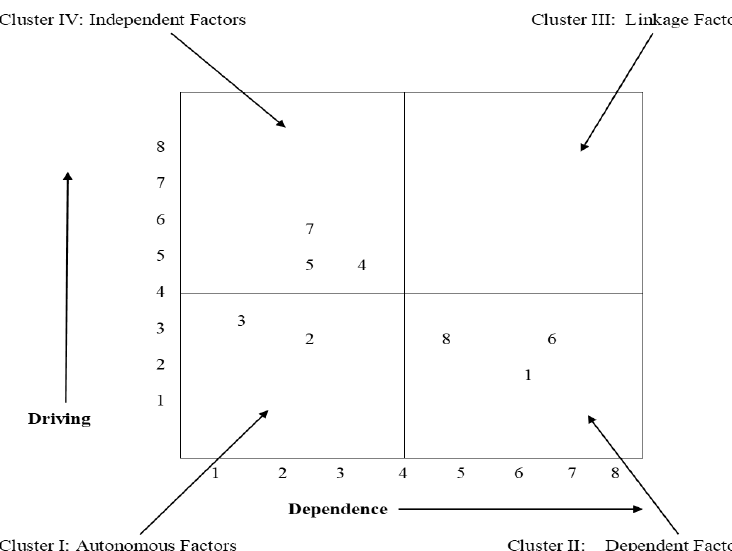
Figure 1. Fuzzy MICMAC Analysis.